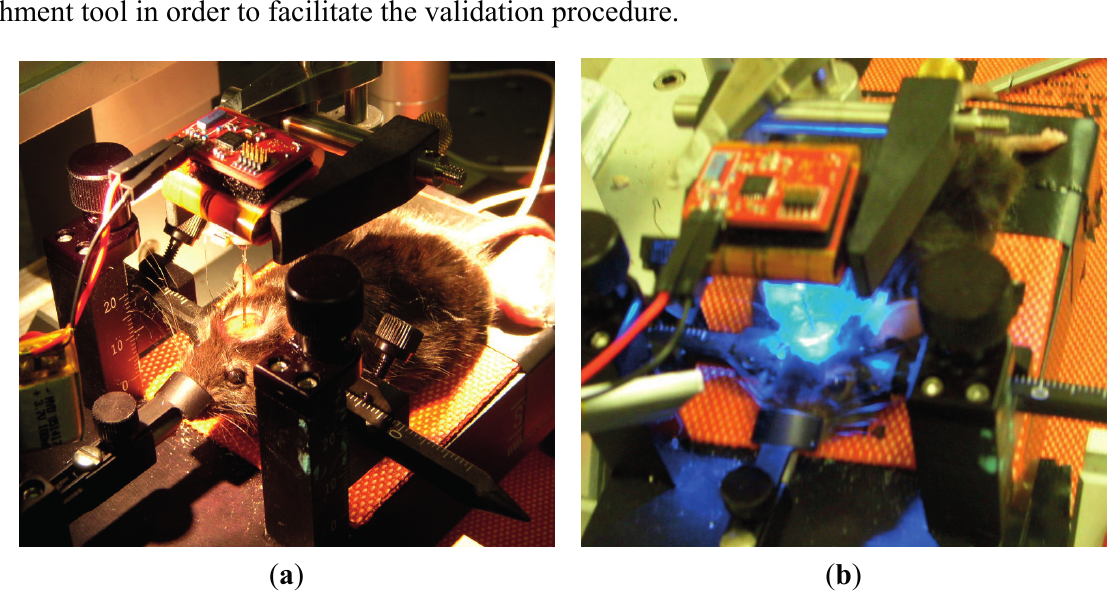
Figure 12. ( a ) Head fixed in vivo setup picture; ( b ) The measured in vivo data were transmitted between the headstage and a base station located 2 m